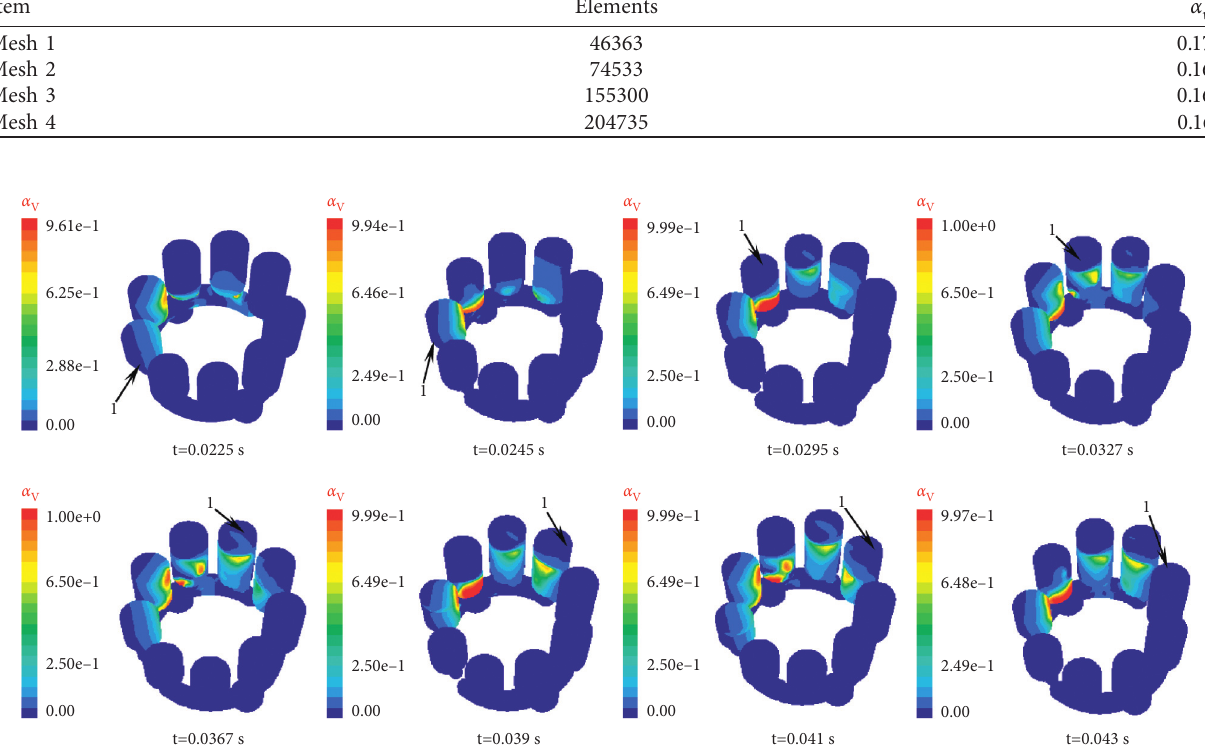
Figure 4: Distribution contours of gas volume fraction of no.1 plunger cavity [30].